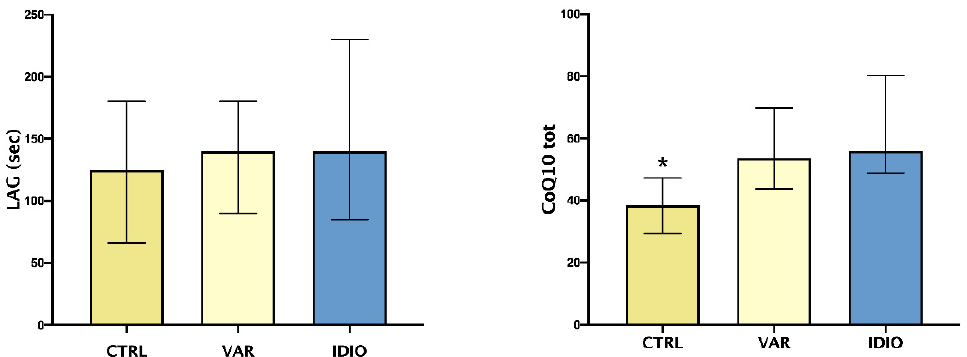
Figure 2. Oxidative stress and seminal fluids: median and IQ ranges of seminal plasma total antioxidant capacity (TAC), expressed as LAG phase, and total coenzyme Q10 (CoQ10 tot). Controls seminal fluids (CTRL), varicoceles (VAR), idiopathic oligo- asthenozoospermia (IDIO). * p < 0.05 vs the other two